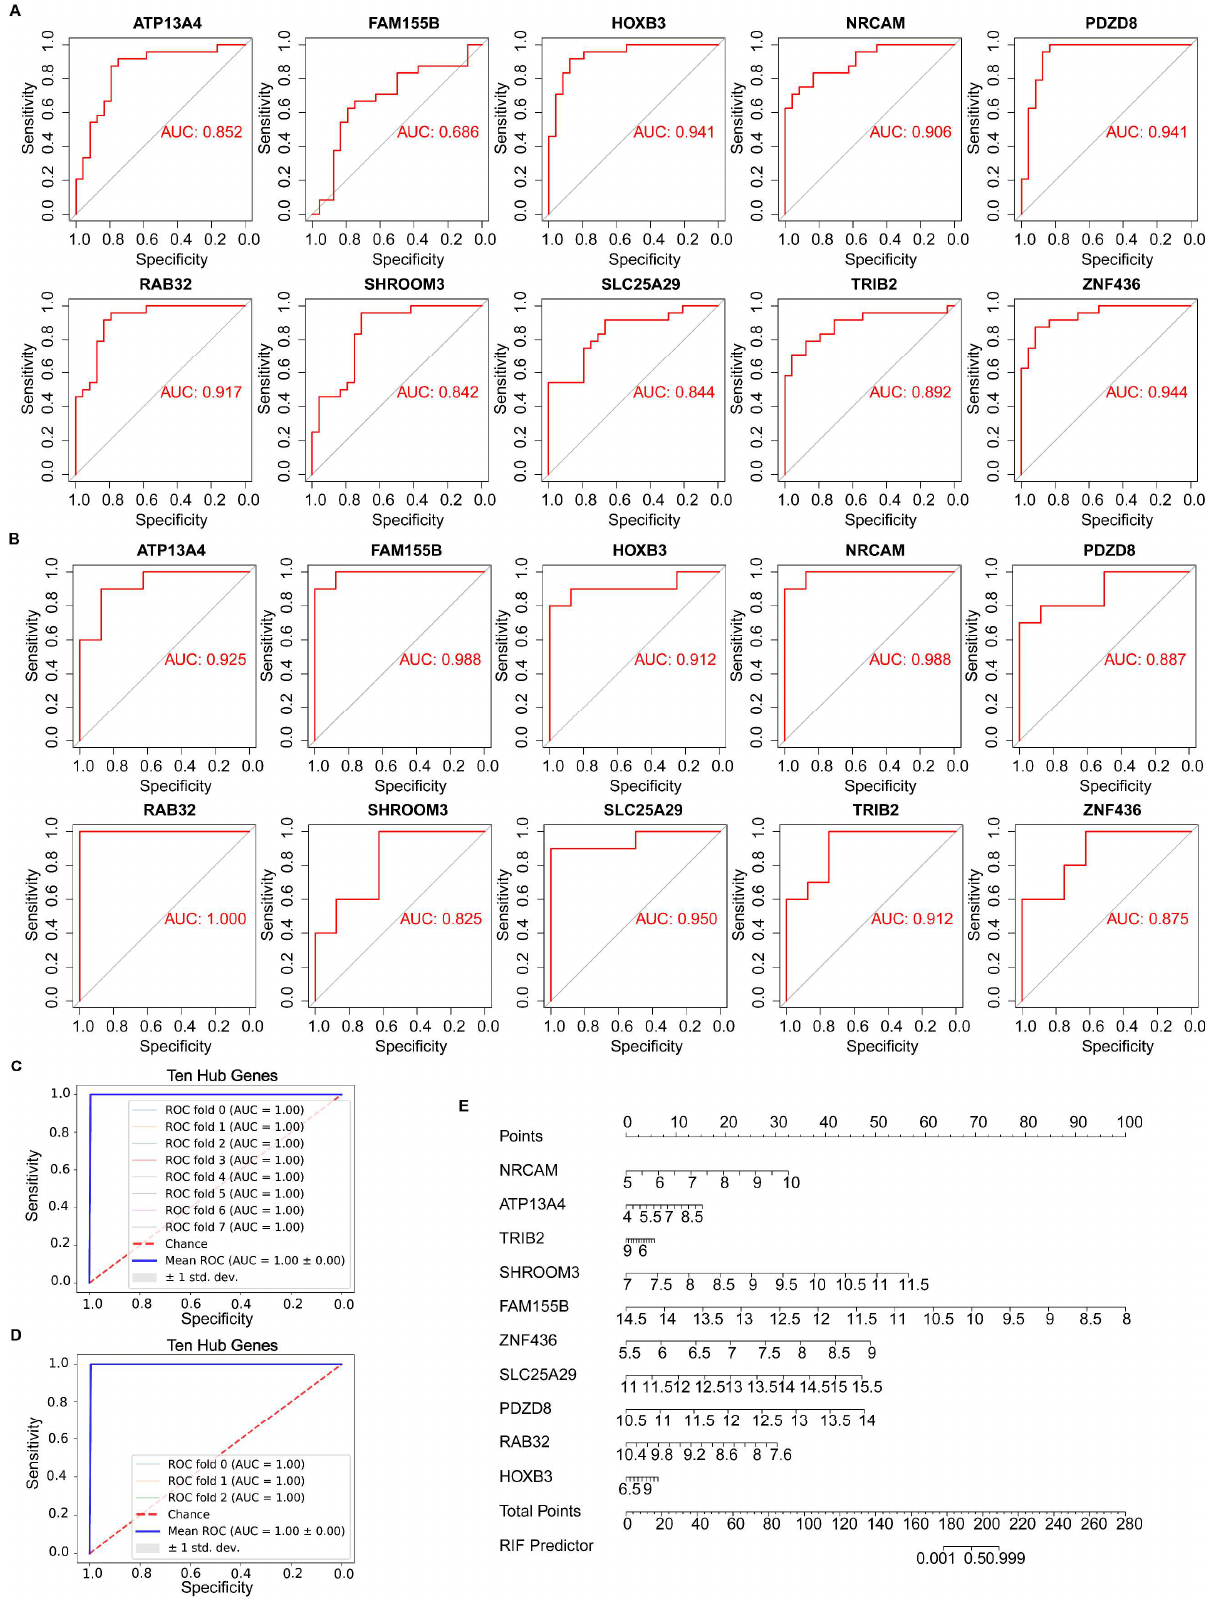
Figure 5. Identification of the hub gene expression levels. The ten hub genes in the ( A ) GSE111974 and ( B ) GSE92324 datasets. The unpaired Student’s t test was applied.